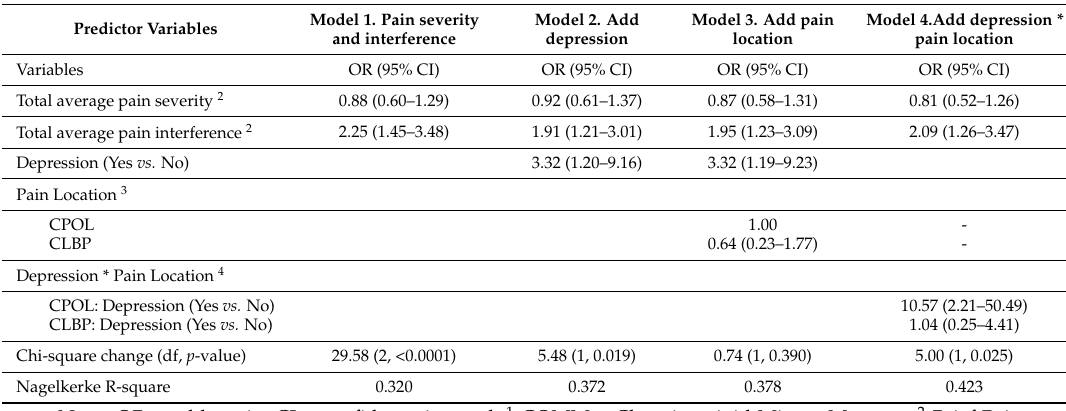
Table 4. Logistic regression models for opioid misuse risk (COMM 1 ) (n =